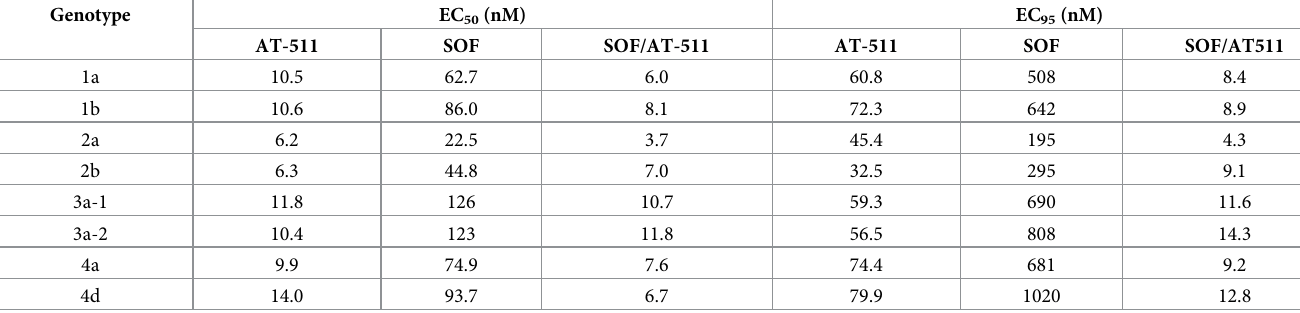
Table 2. Pan-genotypic antiviral activity of AT-511 in a panel of replicons containing HCV constructs from clinical isolates. Genotype